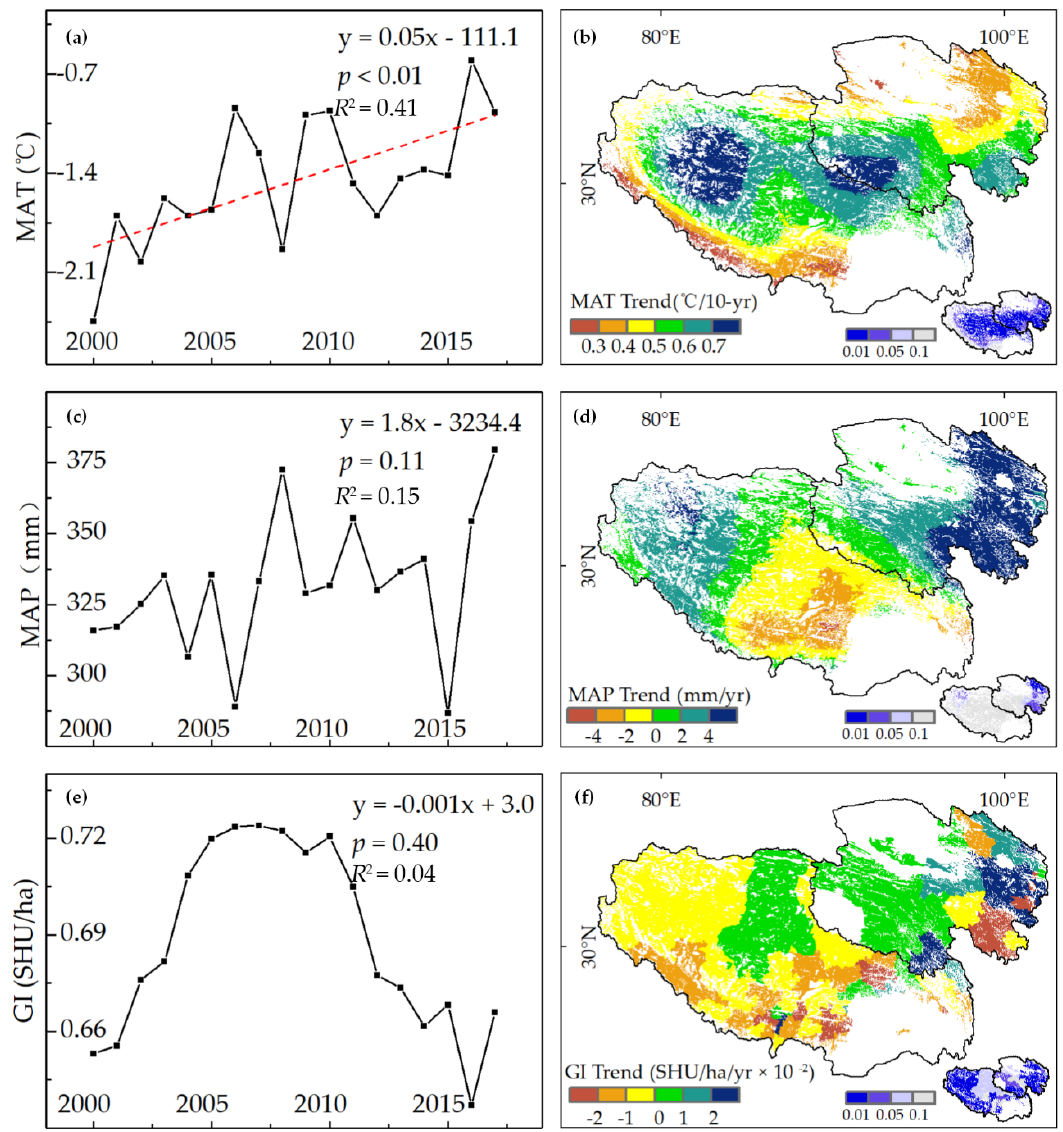
Figure 2. The spatiotemporal patterns of MAT ( a,b ), MAP ( c,d ), and GI ( e,f ) on the QTP from 2000 to 2017. MAT, MAP, and GI represent mean annual temperature, mean annual precipitation, and grazing intensity, respectively. Small maps at the bottom represent the ranges of significance levels.